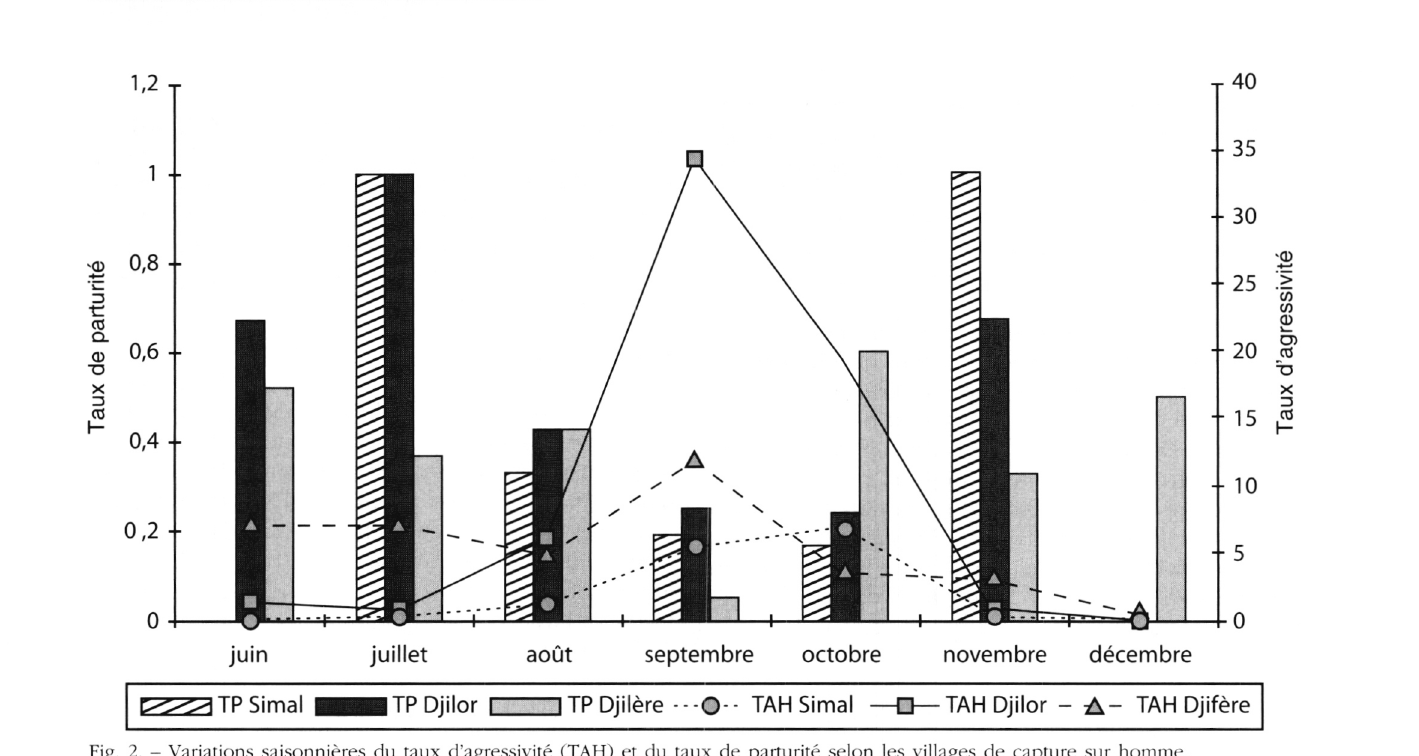
Fig. 2. - Variations saisonnières du taux d’agressivité (TAH) et du taux de parturité selon les villages de capture sur homme.